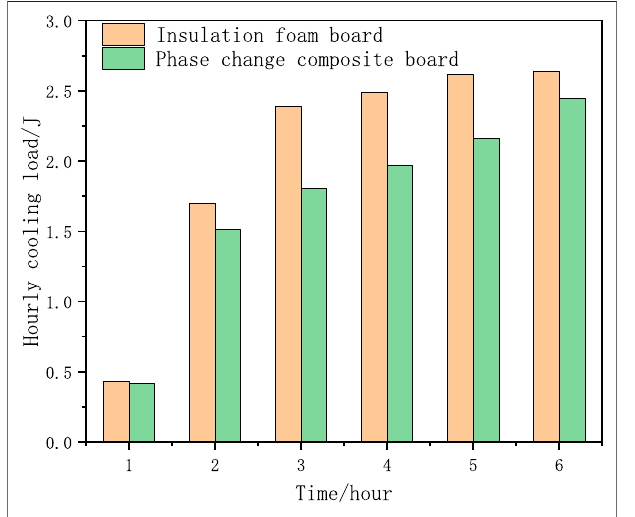
FIGURE 18 | Simulation results of the indoor temperature with various materials in a summer design